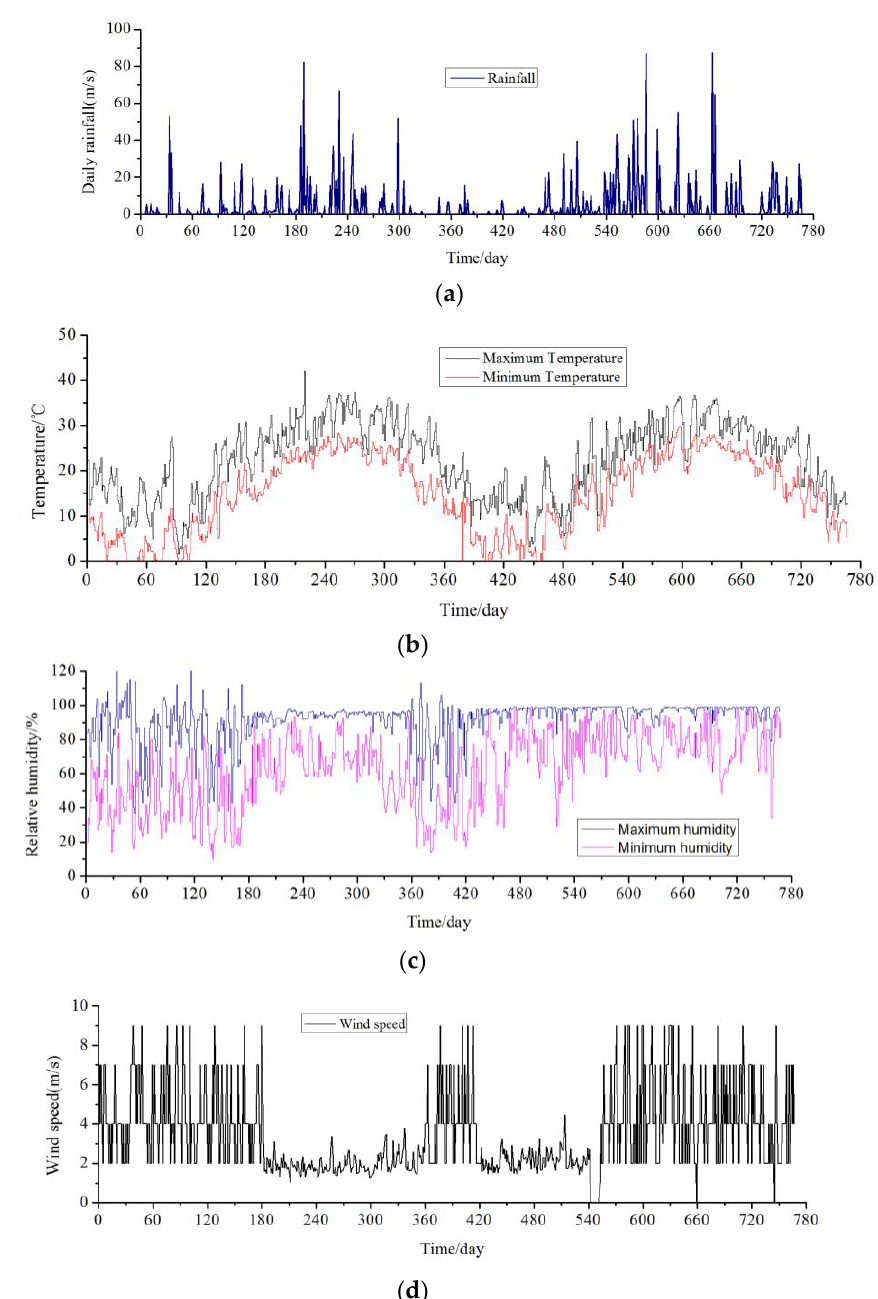
Figure B1. AReal-time Monitoring Climatic Parameters: ( a ) Daily Rainfall; ( b ) Daily Maximum and Minimum Air Temperatures; ( c ) Daily Humidity; ( d ) Daily Average Wind Speed.